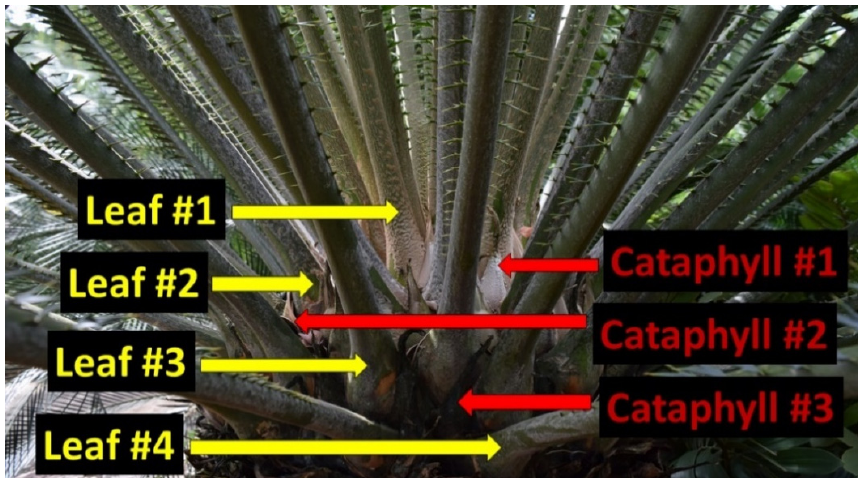
Figure 1. Production of cataphylls (red arrows) unambiguously demarcates the sequential separation of chronological leaf flushes (yellow arrows) exhibiting different historical leaf construction dates for arborescent cycad plants. The youngest leaves (#1) are apical to the youngest cataphylls (#1). This cycad plant contains leaves of four distinct age categories.